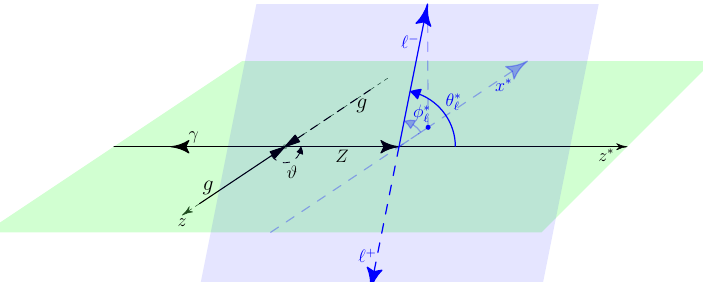
Figure 10 . Kinematic variables for the process gg → Z ( f ¯ f ) γ . The scattering plane is defined by the incoming gluons and outgoing Z/γ bosons. The polar angle (scattering angle) of the Z boson is defined as ϑ , ~z ∗ is defined as the ˆ z ∗ -axis in the rest frame of the Z boson along the direction of the Z boson momentum, and the ˆ x ∗ − ˆ z ∗ plane is spanned by the vector ~z ∗ and the direction of the initial gluon motion. The polar and azimuthal angles of the leptons in the rest frame of the Z boson are θ ∗ and φ ∗ ‘ ‘